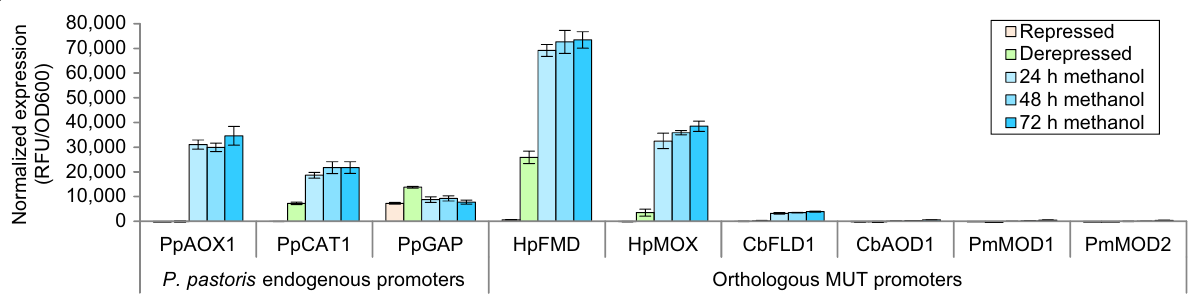
Fig. 1 Orthologous MUT promoters outperform P. pastoris endogenous promoters. Reporter protein fluorescence of all orthologous and P. pastoris endogenous promoters tested. The orthologous MUT promoters of different methylotrophic yeasts were cloned upstream of an enhanced green fluorescent protein (eGFP) and transformed into P. pastoris . The strains were cultivated in deep well plates (DWPs) on BMD1 (glucose) media and subsequently induced with methanol (Weis et al. 2004; Vogl et al. 2016). Reporter protein fluorescence and OD 600 were measured under glucose repressed (16 h) and derepressed (60 h) conditions and different time points of methanol induction. Fluorescence measurements were normalized per OD 600 . Mean values (MVs) and standard deviations (SDs) of biological quadruplicates are shown